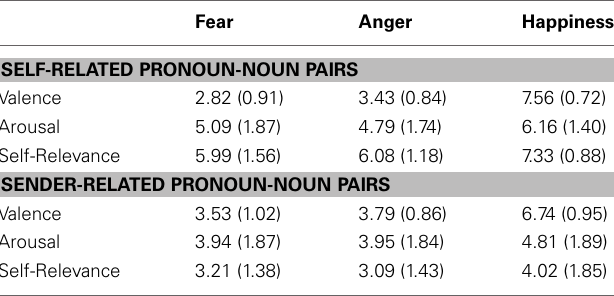
Table 4 | Experiment1: mean valence, arousal, and self-relevance ratings of self-related and sender related pronoun-noun pairs obtained after the experimental